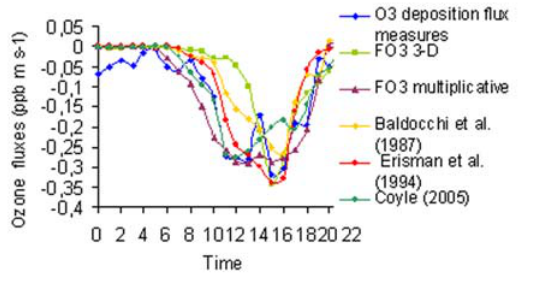
FIGURE 2. Ozone deposition fluxes and FO 3 for anthesis at 2000. Authors references indicate the resistance-type model used. Data compared are 1-h average values taken from 10-min average